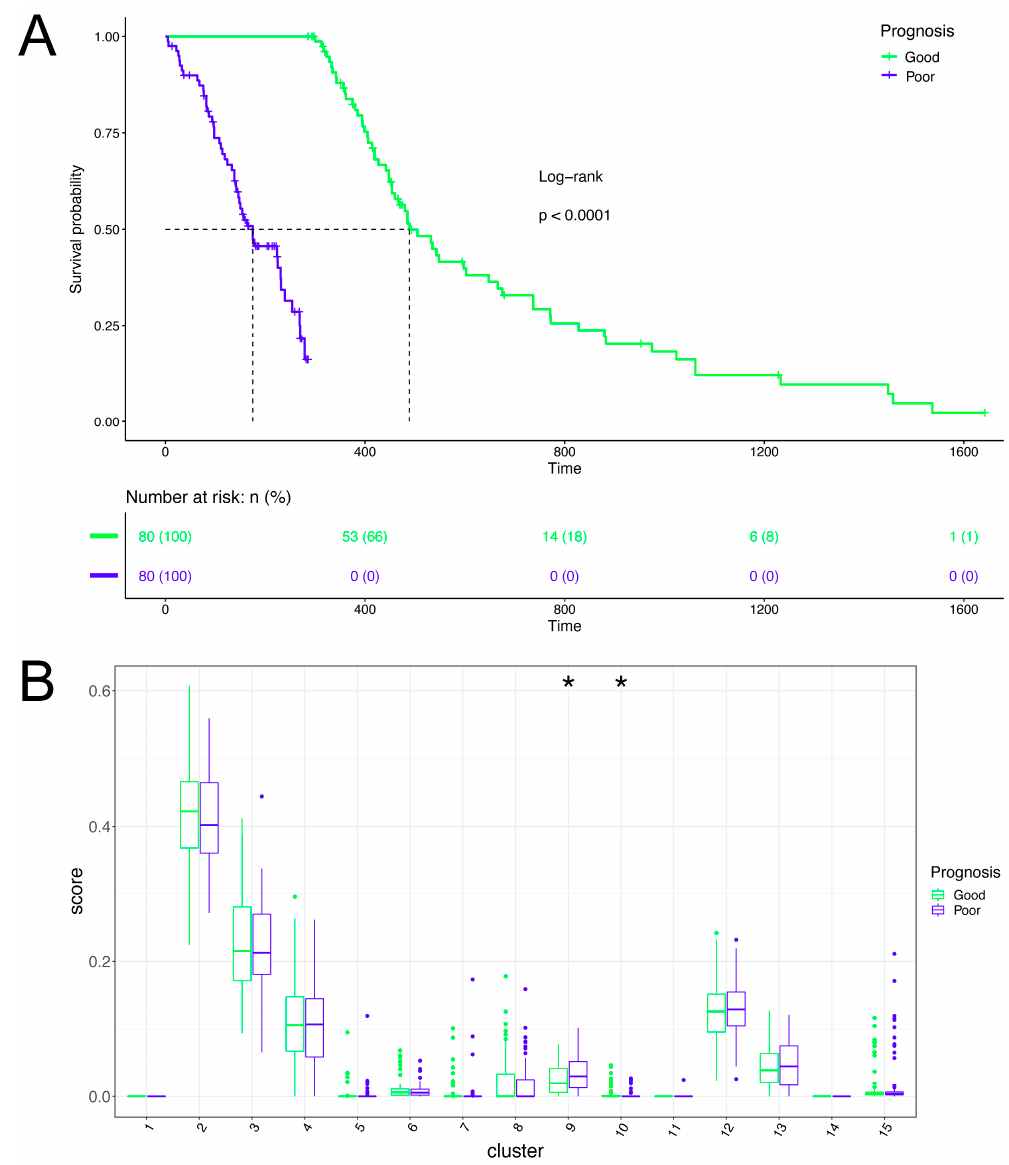
Figure 6. Prognostic analysis of cell clusters. ( A ) Survival curves of different prognosis groups. The X-axis is time (days), and the Y-axis is survival rate. Patients are divided into two groups: good-prognosis and poor-prognosis. Survival curves are drawn, and a log-rank statistical test is performed. ( B ) Box diagram of cell cluster content. The X axis shows 15 cell clusters of adult GBM cells, and the Y axis shows CIBERSORT score (cell content). * represents p <0.05 (Wilcoxon rank-sum test).